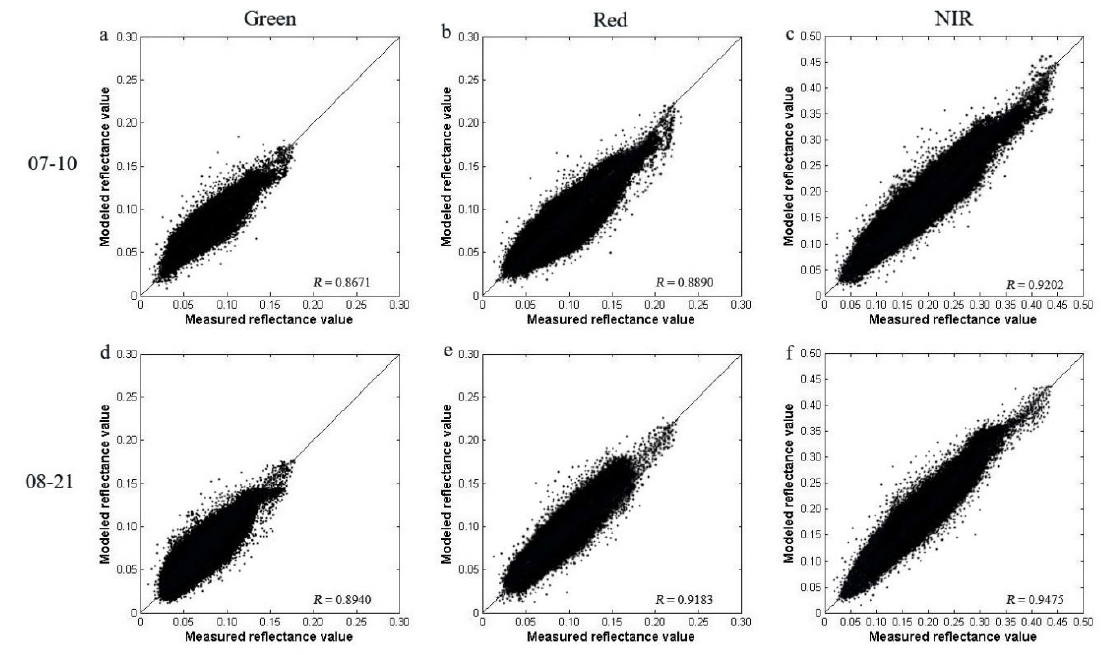
Figure 5. The scatter plots of the reflectance of the predicted values and the true values. ( a – c ) are the scatter plots of the green, red, and NIR bands on 07-10; ( d – f ) are the scatter plots of the green, red, and NIR bands on 08-21.